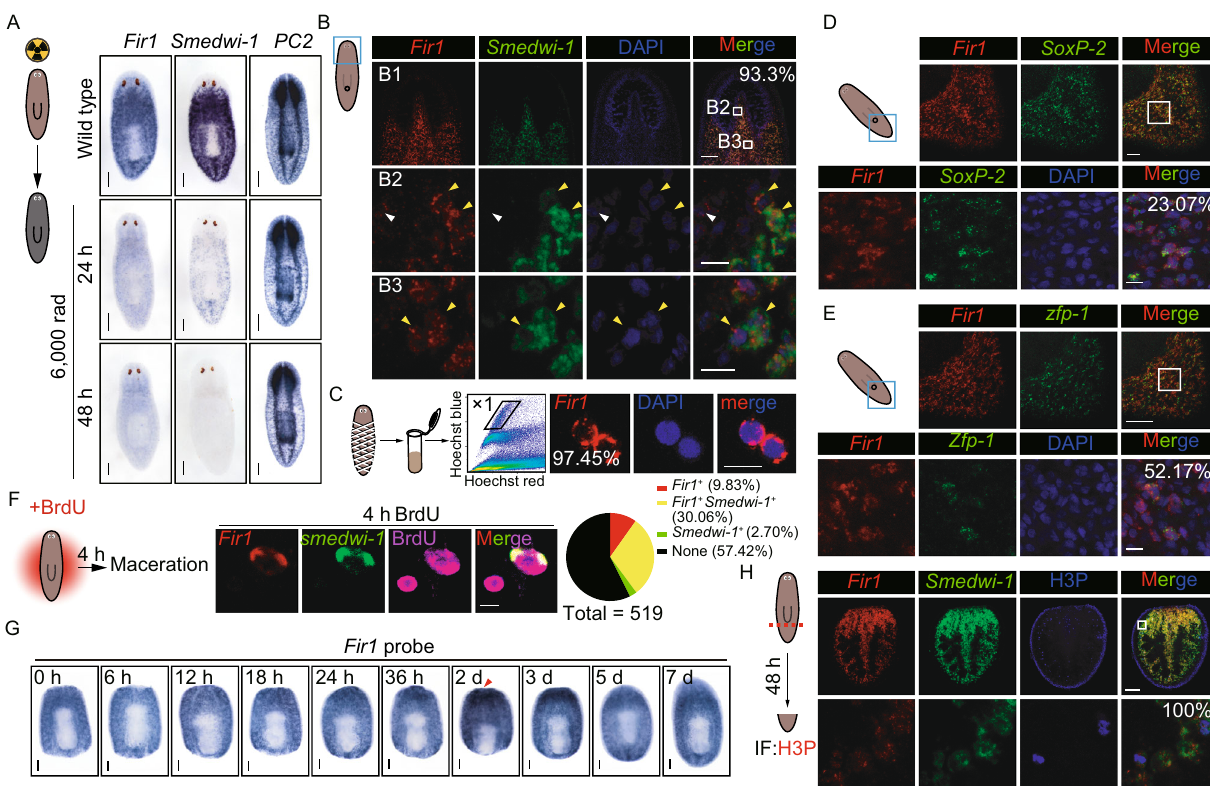
Figure 3. Fir1 mRNA is mainly expressed in neoblasts. (A) Colorimetric WISH of animals after 6,000 rads irradiation exposure showing that Fir1 mRNA levels were irradiation sensitive. For each condition, n = 10 animals. Scale bars, 200 μ m. (B) Representative confocal projections (ten 1 μ m z-stacks) of planarian head, stained with Fir1 (red), smedwi-1 (green) and DAPI (blue). (B1) Head of the planarian. (B2) Zoom-in in the brain region. (B3) Zoom-in post brain. White arrowheads highlight Fir1 + smedwi-1 − cells; yellow arrowheads point at double positive cells. The number indicates the percentage of Fir1 + cells co-expressing smedwi-1 ( n > 500 cells). Ventral views, anterior up. Scale bars, B1: 100 μ m; B2, B3: 10 μ m. (C) Fir1 expression in neoblasts (referred to as X1 cells) sorted using FACS was detected using FISH. The number indicates the percentage of X1 cells expressing Fir1 ( n > 400 cells). Scale bar, 10 μ m. (D) Double FISH of Fir1 (red) and soxP-2 (green) with DAPI (blue). Box indicates zoomed-in region. Ventral view of planarian tail. The number indicates the percentage of Fir1 + cells co-expressing soxP-2 ( n > 500 cells). Scale bar, upper panel: 50 μ m; lower panel: 10 μ m. (E) Double FISH of Fir1 (red) and zfp-1 (green) with DAPI (blue). Box indicates zoomed-in region. Ventral view of planarian tail. The number indicates the percentage of Fir1 + cells co-expressing zfp-1 ( n > 500 cells). Scale bar, upper panel: 50 μ m; lower panel: 10 μ m. (F) Representative confocal plane from macerated planarians subjected to a 4 h BrdU pulse and labeled by Fir1 and smedwi-1 FISH probes and BrdU IF. Pie chart quanti fi es the percentage of BrdU + cells labeled with Fir1 and smedwi-1 FISH probes ( n = 519). Scale bar, 5 μ m. (G) Colorimetric WISH of regenerating middle pieces for Fir1 . Ventral views, for each time point, n = 10 animals. Scale bars, 200 μ m. (H) Representative confocal projections of tail pieces 48 h following amputation, labelled by Fir1 (red), smedwi-1 (green) and H3P antibody (blue). Box indicates zoomed-in region. The number indicates the percentage of H3P + cells co- expressing Fir1 ( n > 100 cells). Scale bars, upper panel: 100 μ m; lower panel: 10 μ